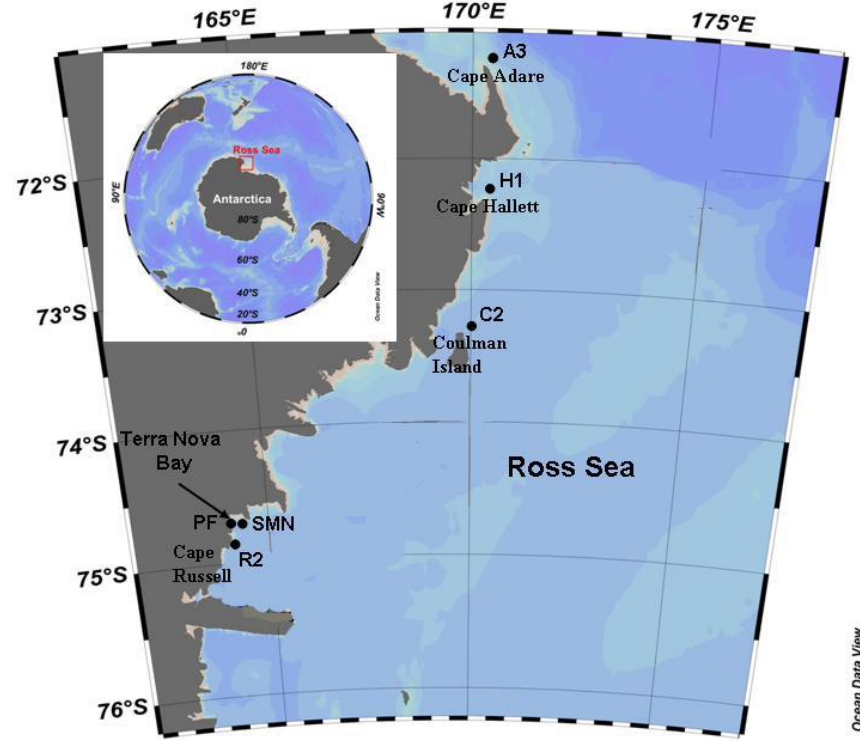
Figure 1. Antarctic study area and location of the sampling stations.